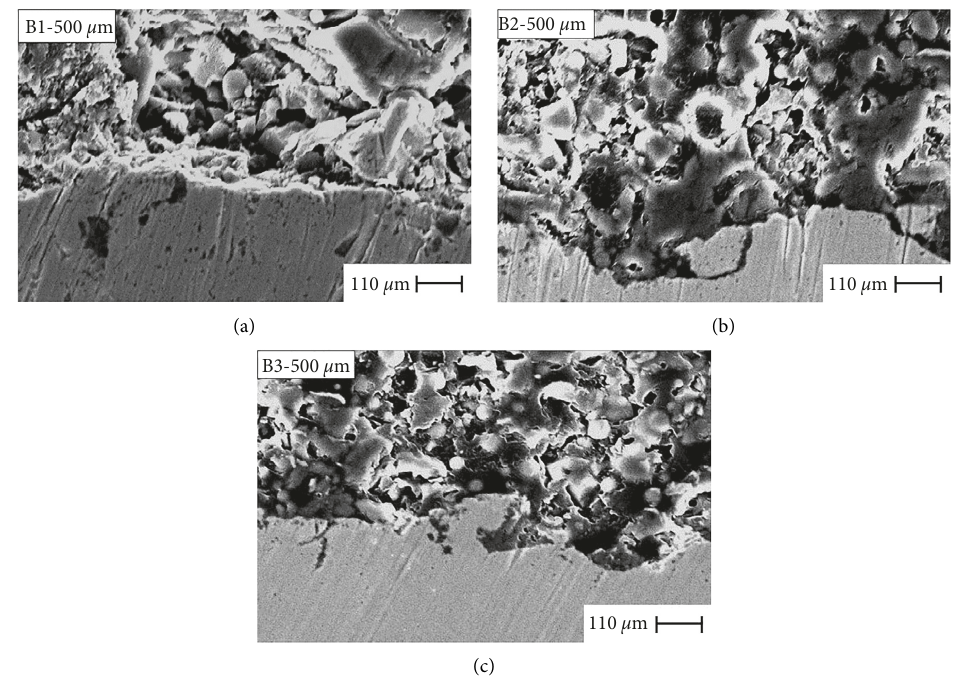
Figure 11: Cross section microstructure of coating (B). (a) B1. (b) B2. (c) B3.